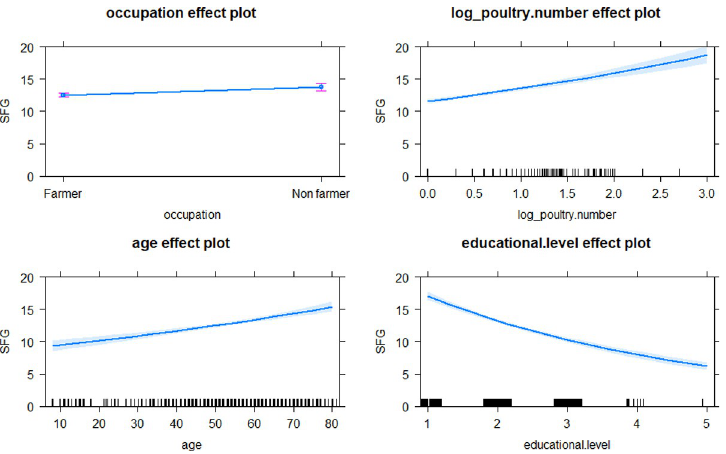
Fig 5. Effect plots of explicative variables after best model fitting with GLM to estimate level of SFG exposures in inhabitants of Saen Thong Subdistrict, Nan Province. Marks on the X-axis represent individual observations.